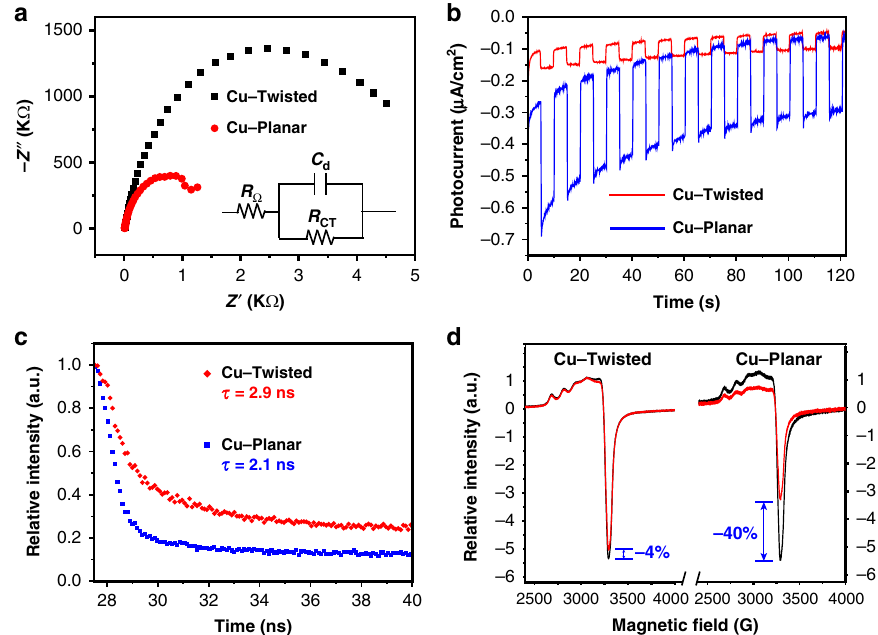
Fig. 3 Characterisation of the diode-like photoelectronic behaviours. Comparisons of a EIS, b transient photocurrent responses, c fl uorescence lifetimes, d EPR spectra of Cu – Twisted and Cu – Planar , respectively.